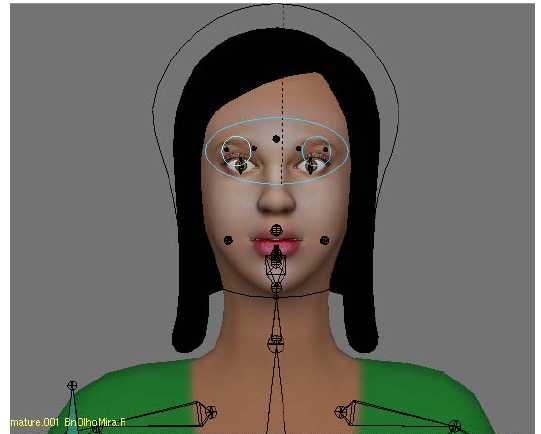
Figure 11 – Face bones of 3D Avatar.